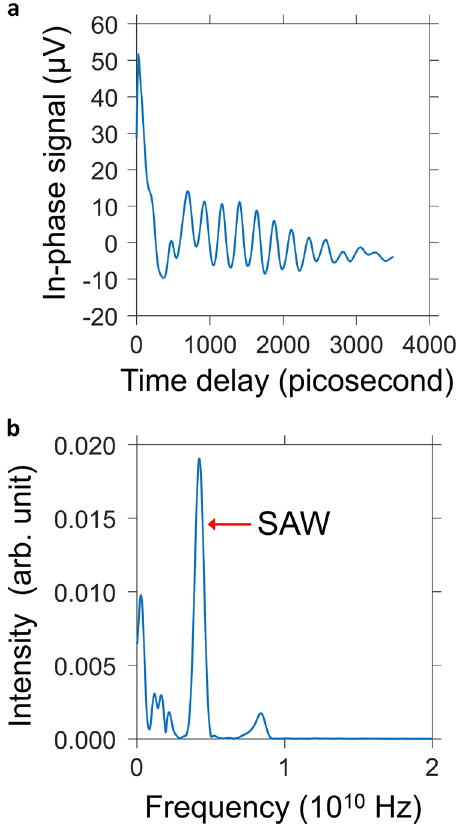
Fig. 4 Example outputs from a TDTR measurement showing in both the time domain ( a ) and the frequency domain ( b ). In the time domain, periodic modulation is due to the interaction of the SAW with the PDMS parallel line grating, which leads to a temporary standing wave before it dies out. The SAW velocity is equal to the wavelength (700 nm) times the SAW frequency